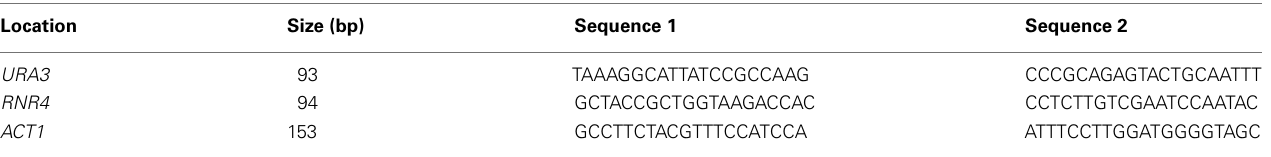
Table 3 | List of primers used for quantitative